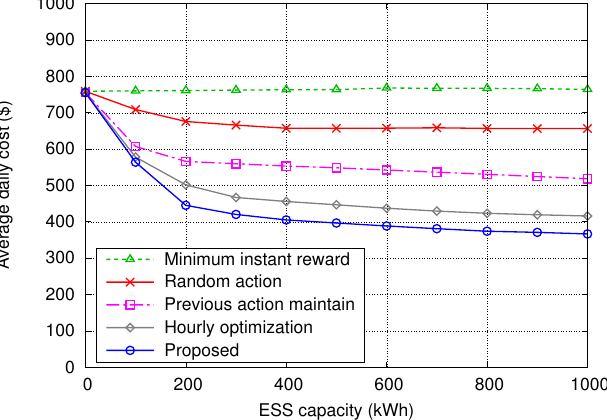
Figure 8. Average daily cost with respect to ESS